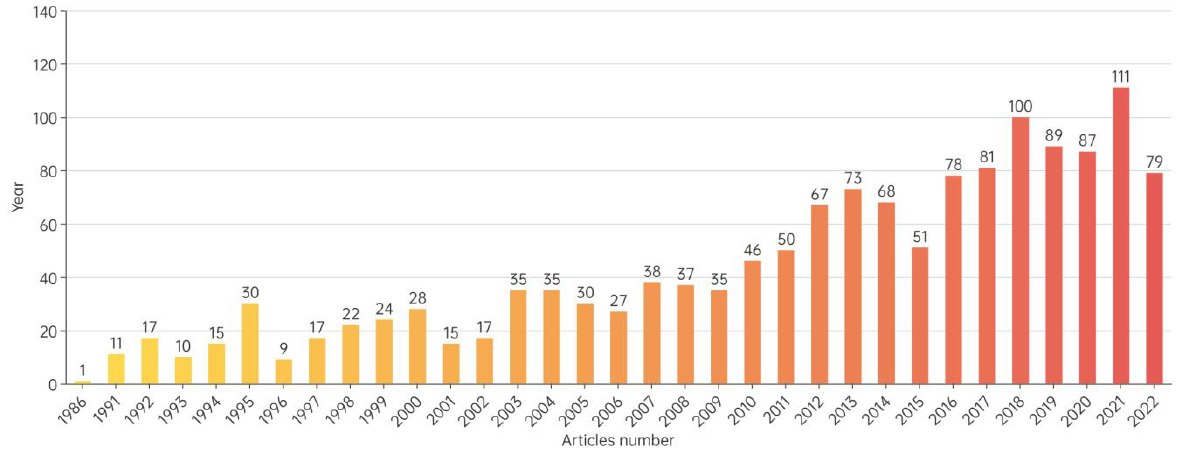
Figure 3. Number of FCMNCE research articles published from 1986 to 2022.